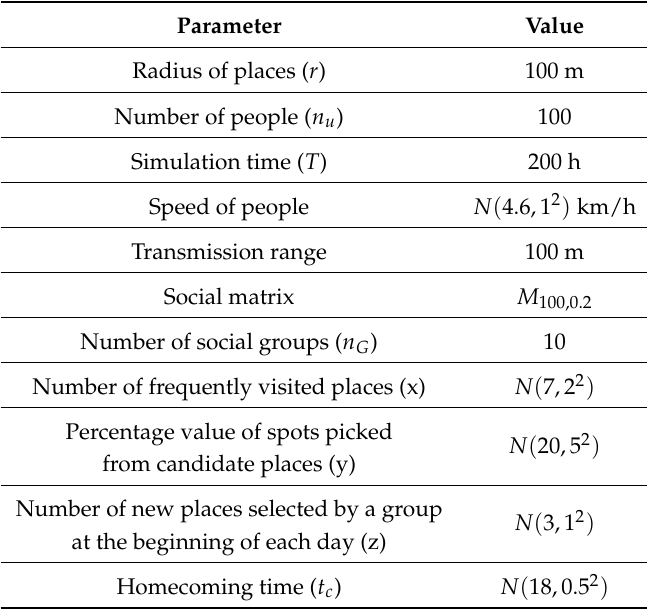
Table 2. Simulation